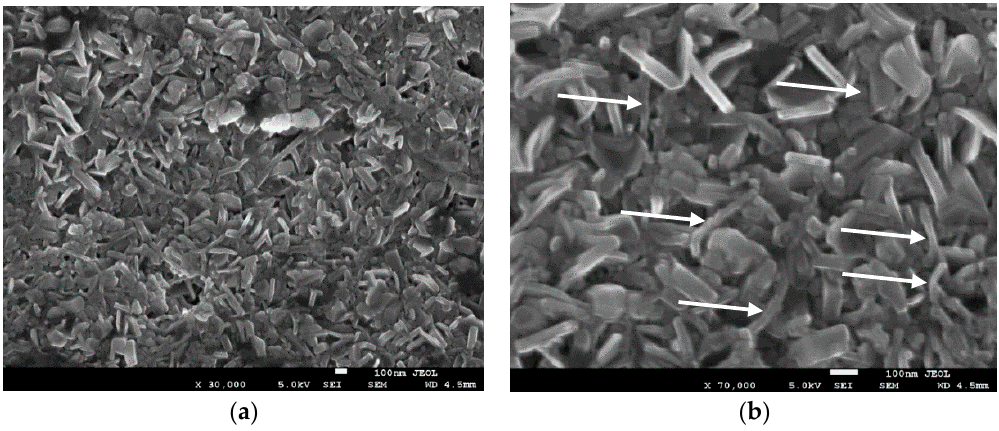
Figure 3. The processed CNT ‐ doped MgB 2 sample after sintering (arrows point to CNTs). ( a ) Low magnification (30,000 × ); ( b ) High magnification (70,000 × ).